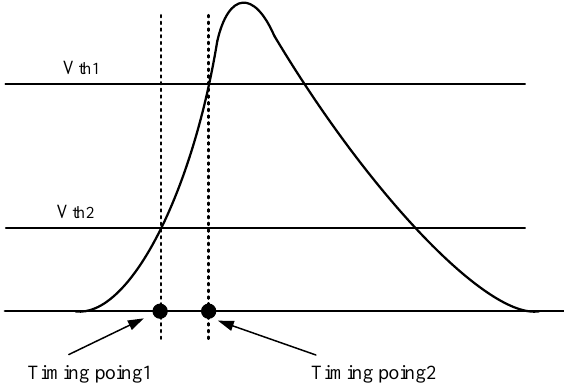
Figure 2. The principle of LED based on different threshold